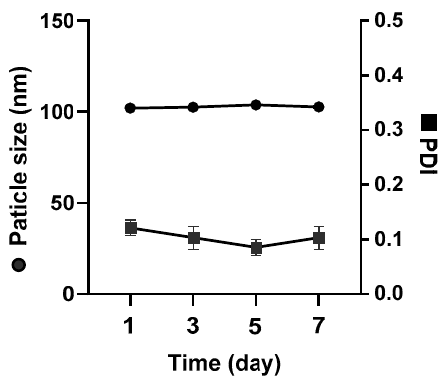
Figure 3. Colloidal stability of the amino-dextran nanoparticle suspension in water over a period of 7 days. Data are presented as the mean ± S.D. ( n = 3).